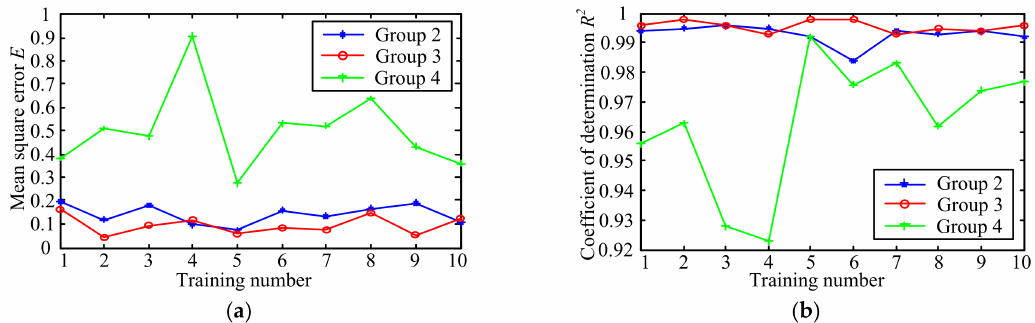
Figure 11. Model performance comparisons of three input variable groups. ( a ) Mean square error; ( b ) Coefficient of determination.